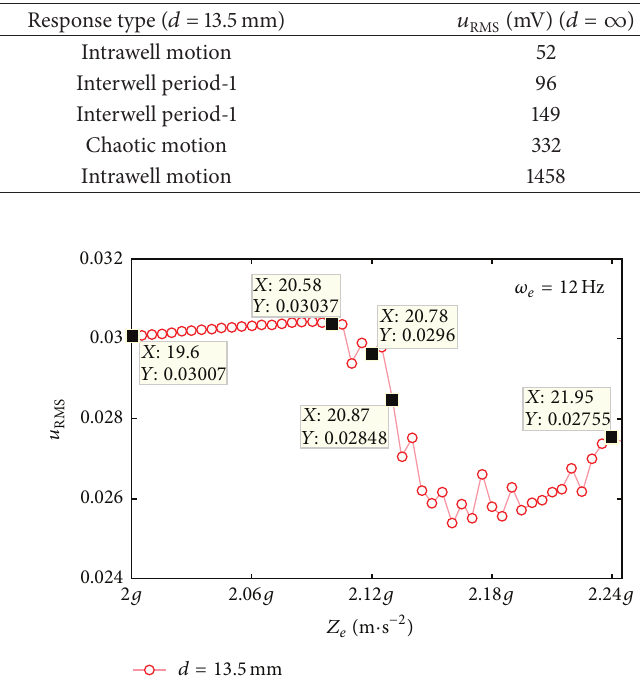
Figure 13: Effective voltage output with increasing 𝑍 𝑒